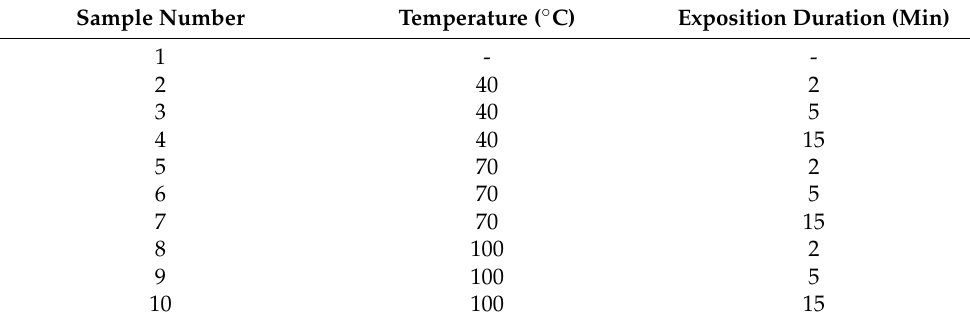
Table 1. Overview of